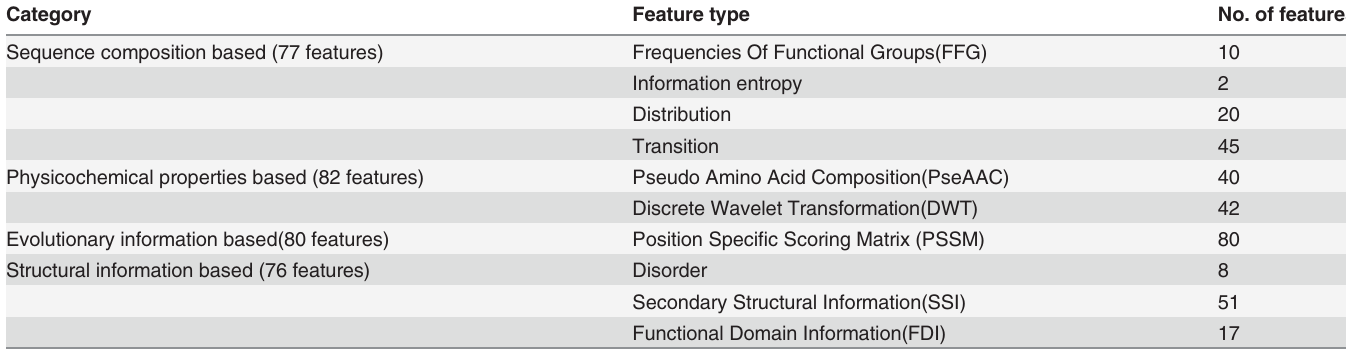
Table 1. Summary of the considered features. Hybrid features are employed by incorporating sequence composition, physicochemical properties, evolutionary and structural information.